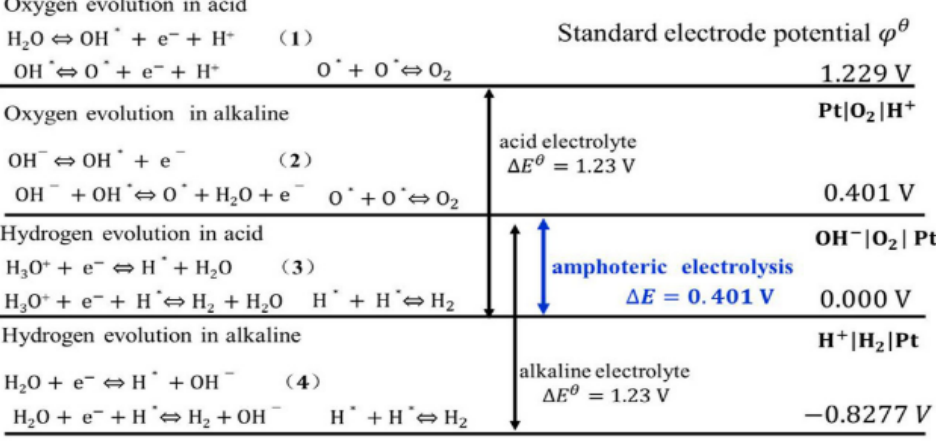
Figure 13. Standard potential for water splitting under different pH conditions [34].